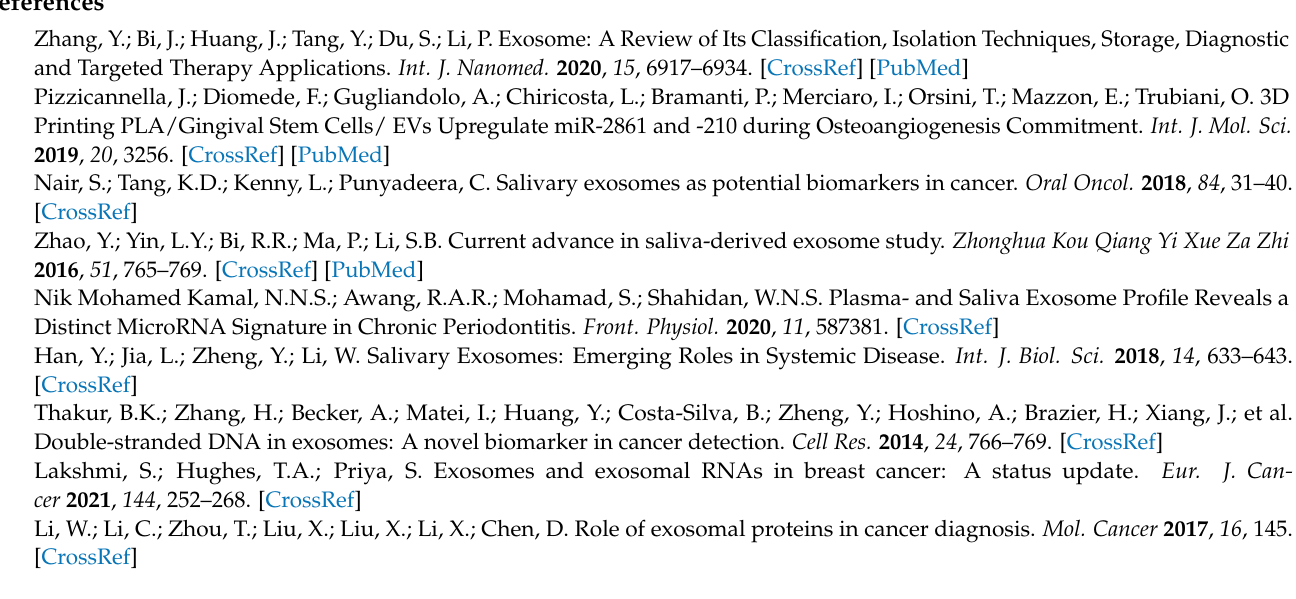
PreD group. Figure S1: Detection of CD63 expression of salivary exosome proteins from 3 hamsters among PreD group. Supplementary File 1: 136 Reactome pathways in the Rattus norvegicus database and 132 Reactome pathways in the Mus musculus